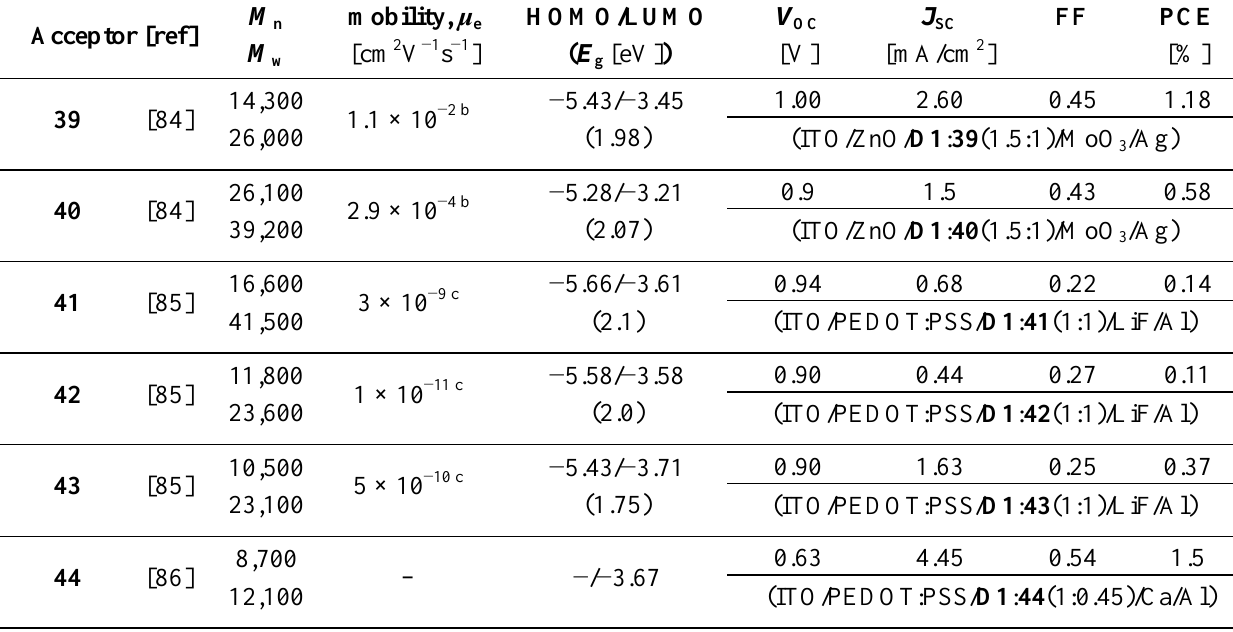
Table 5. Other polymer acceptors containing electron-withdrawing units a .